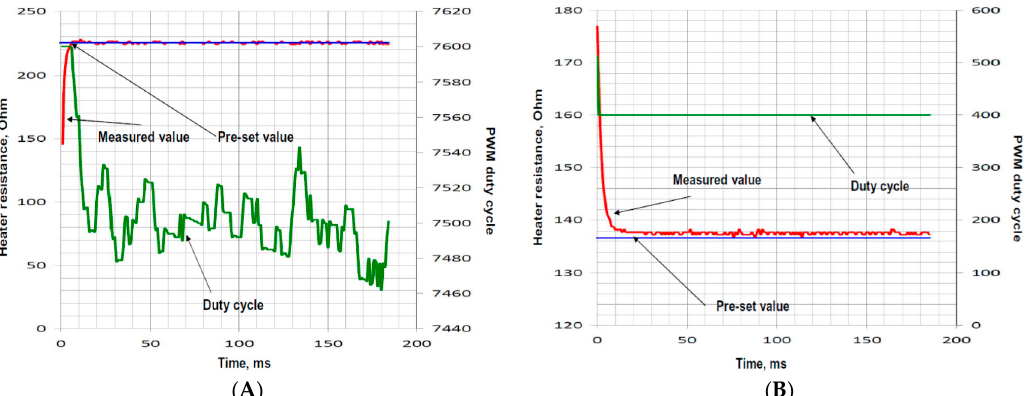
Figure 3. ( A ) Heating process of MEMS gas sensor. Pre-set resistance corresponds to working temperature of 350 °C. 100% duty cycle of PWM corresponds to 8000 value at the right axis. τ 90 of the heating process is of ~8 ms; ( B ) Cooling process of MEMS gas sensor. Pre-set resistance corresponds to working temperature of 350 °C. 100% duty cycle of PWM corresponds to 8000 value at the right axis. τ 90 is of ~8 ms.